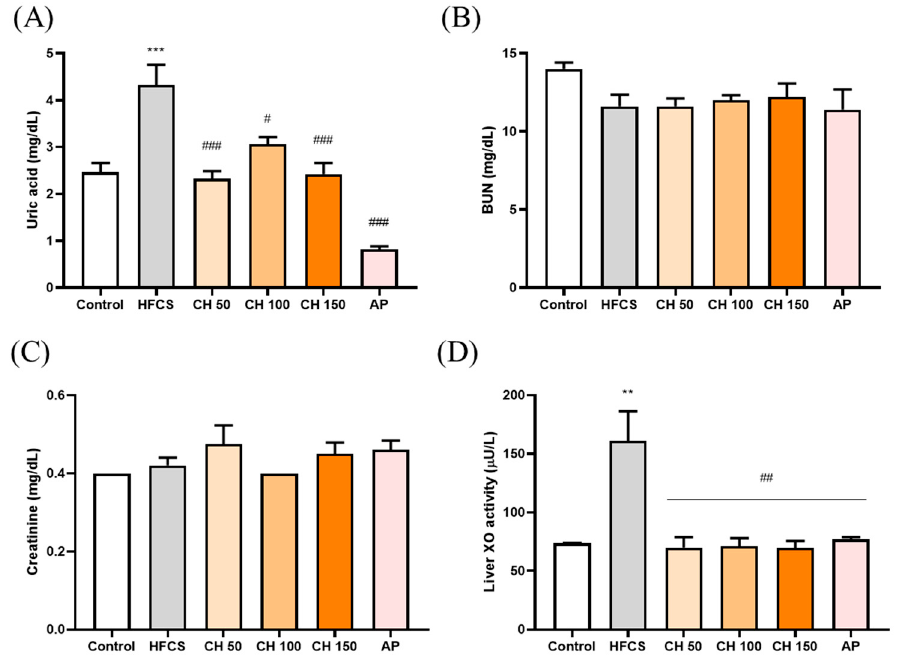
Figure 2. Effects of chrysin on ( A ) serum uric acid levels, ( B ) serum blood urea nitrogen (BUN), and ( C ) serum creatinine, ( D ) liver XO activity. C: control; HFCS: high-fructose corn syrup group (10% high-fructose corn syrup solution); AP: allopurinol (10 mg/kg bw); CH 50: chrysin (50 mg/kg bw); CH 100: chrysin (100 mg/kg bw); CH 150: chrysin (150 mg/kg bw). Data are represented as mean ± SEM ( n = 4–6 per group). ** p < 0.01, *** p < 0.001 versus the control group. # p < 0.05, ## p < 0.01, ### p < 0.001 versus the HFCS group.